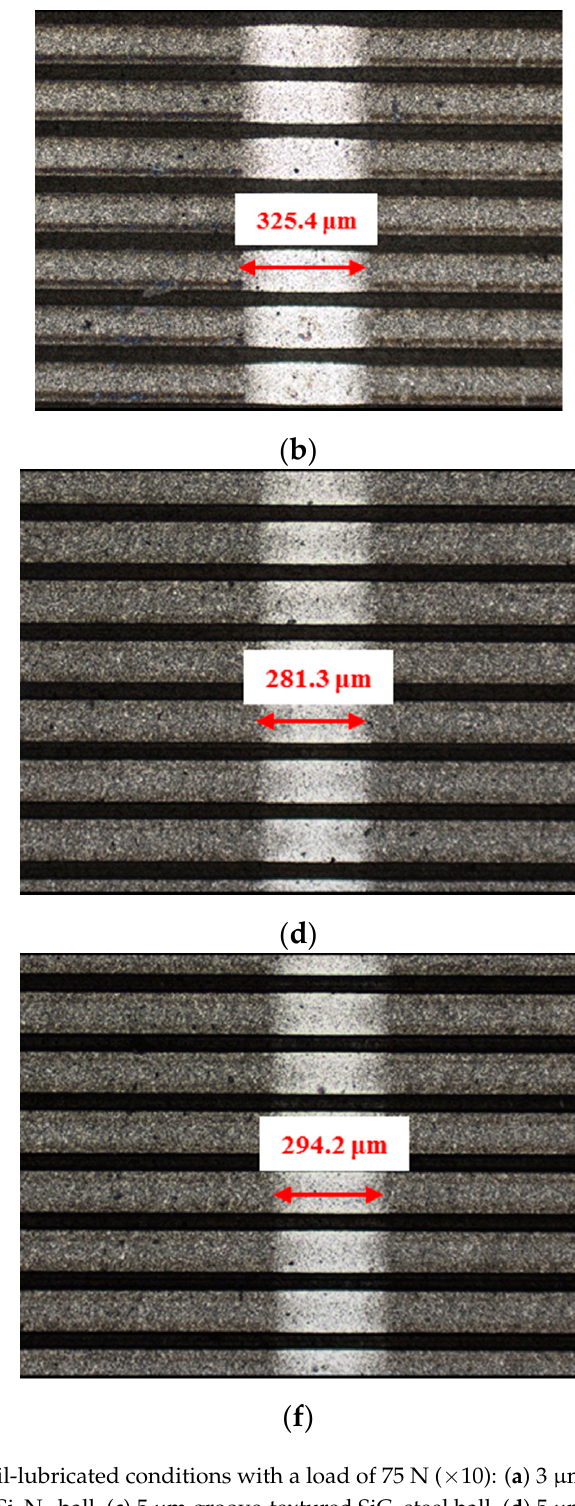
Figure 12. Wear performance of circular-dimple-textured SiC under oil-lubricated conditions with a load of 75 N (×10): ( a ) 3 μ m circular-dimple-textured SiC-steel ball, ( b ) 3 μ m circular-dimple-textured SiC–Si 3 N 4 ball, ( c ) 5 μ m circular-dimple- textured SiC–steel ball, ( d ) 5 μ m circular-dimple-textured SiC–Si 3 N 4 ball, ( e ) 10 μ m circular-dimple-textured SiC–steel ball, and ( f ) 10 μ m circular-dimple-textured SiC–Si 3 N 4 ball.